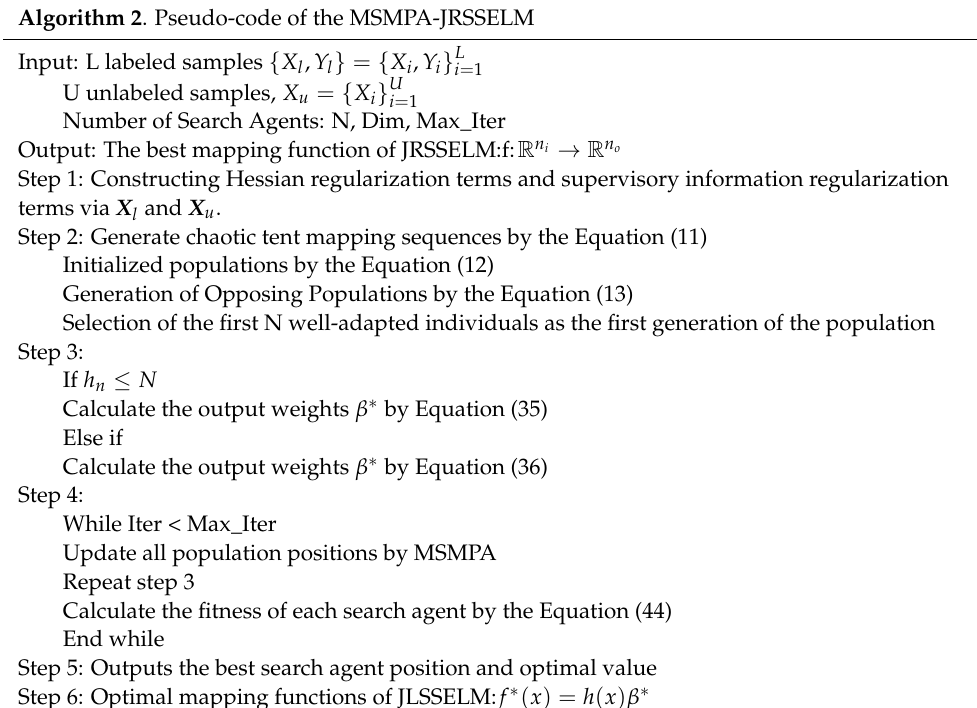
Algorithm 2 . Pseudo-code of the